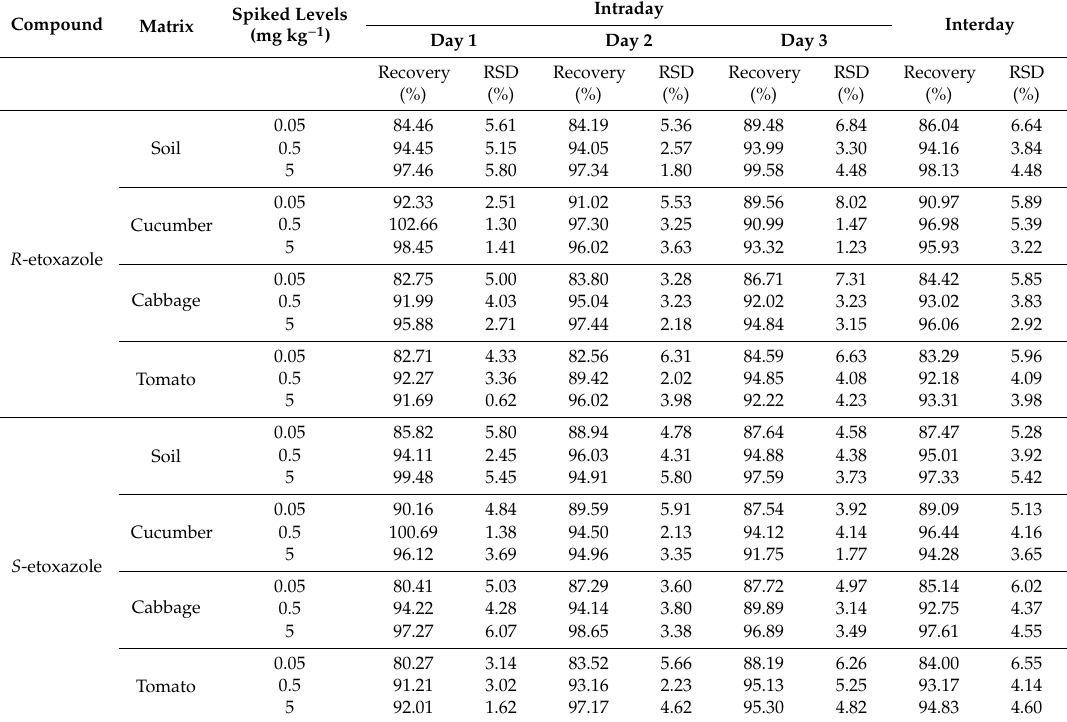
Table 3. Recovery and relative standard deviation (RSD) for etoxazole enantiomers among di ff erent matrixes for three spiked levels ( n =